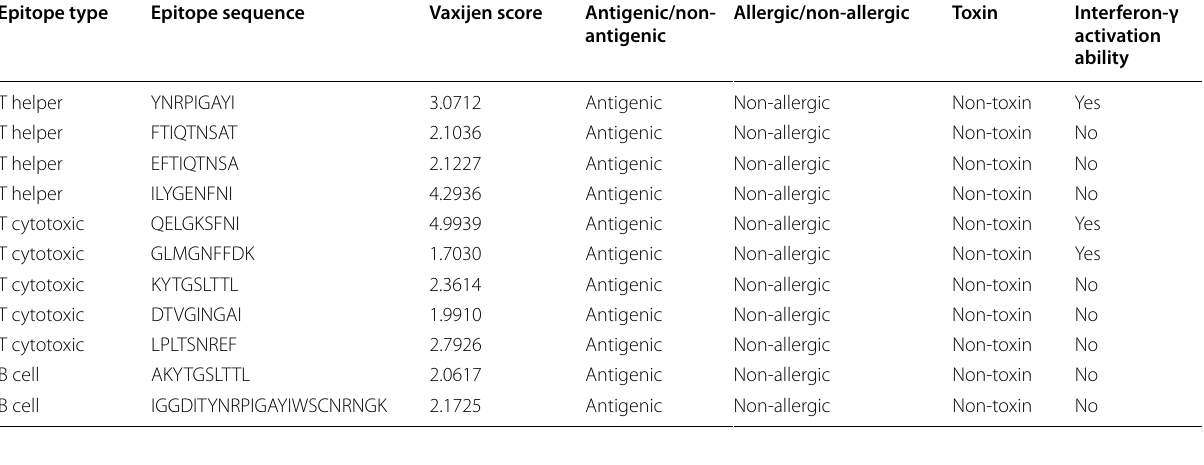
Table 1 List of final epitopes selected for vaccine engineering along with their properties Epitope type